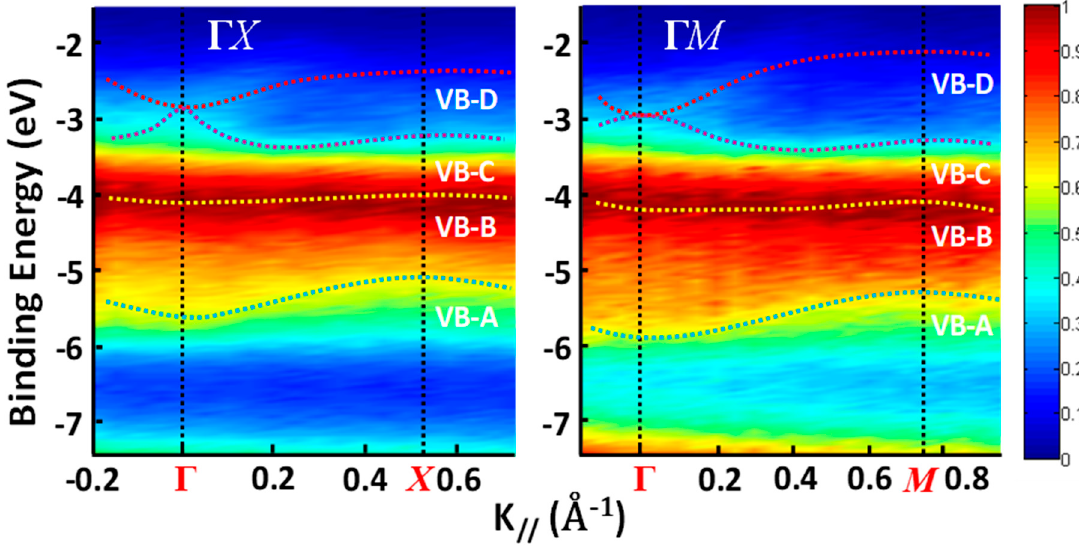
Figure 14. Energy distribution curves (EDCs) of MAPbBr 3 along Γ X and Γ M directions. The color represents the intensity of the photoemission spectrum. From Ref. [104] with permission.